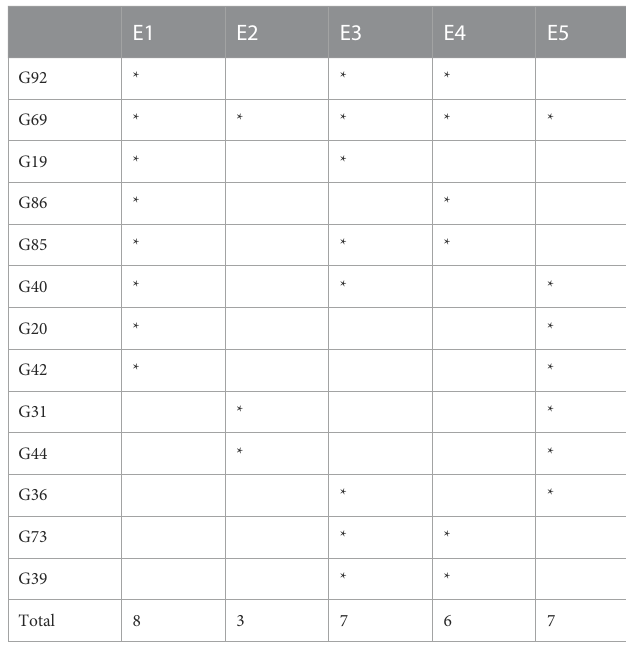
TABLE 2 Top genotypes for high yields across fi ve